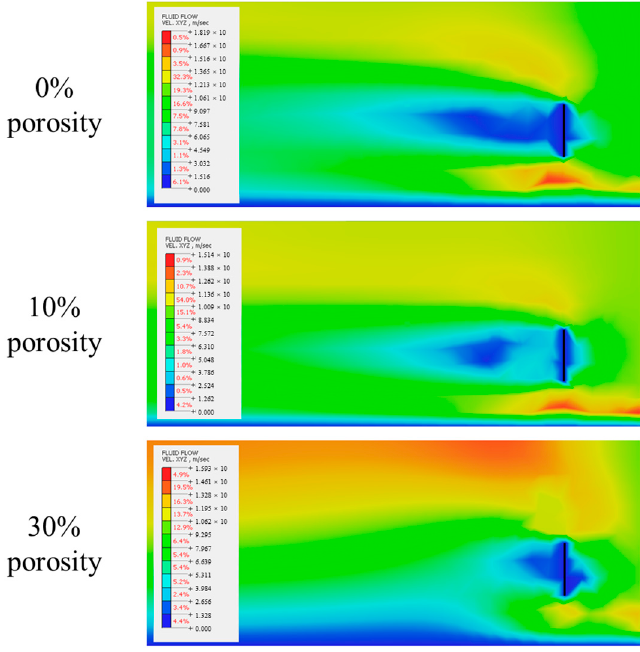
Figure 6. Wind pressure distribution of perforated road sign by porosity.